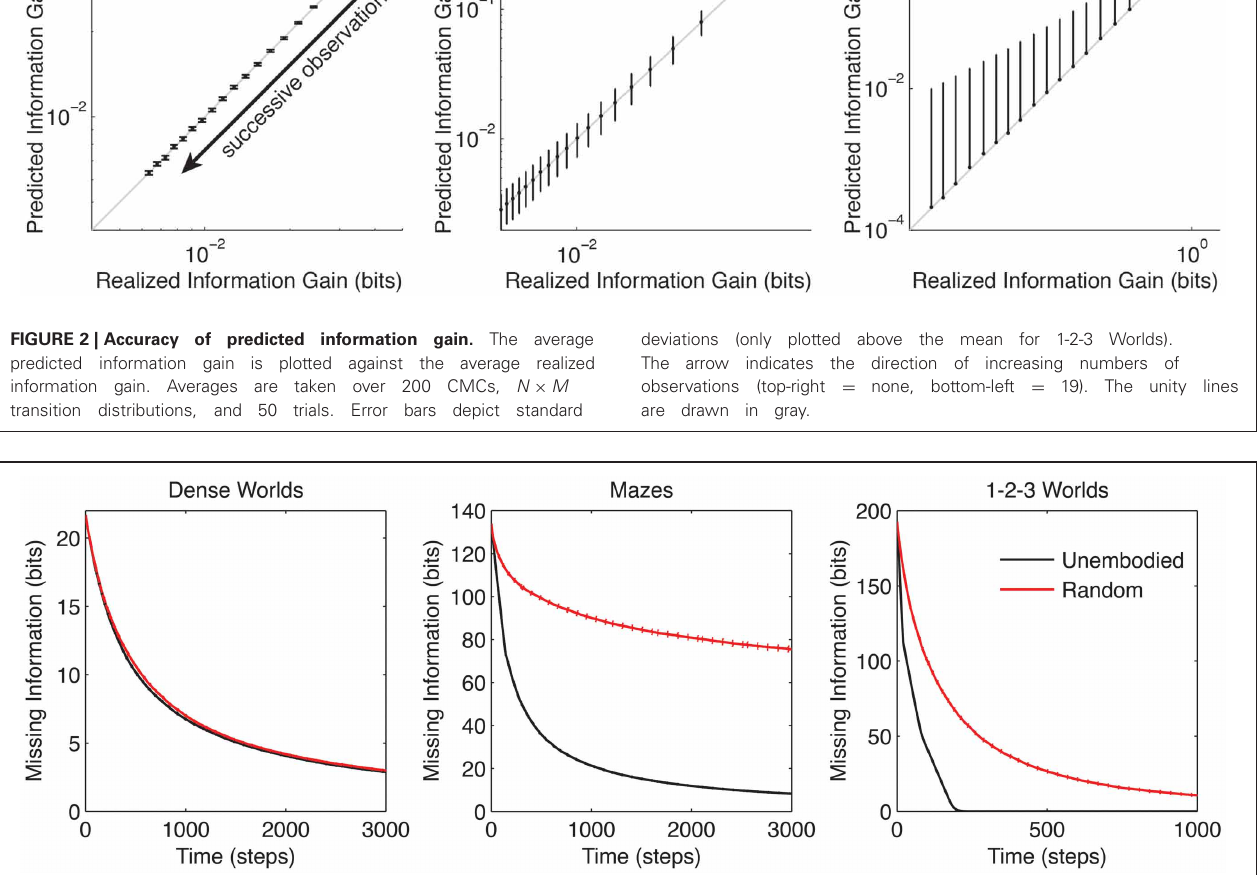
FIGURE 3 | Learning curves for control strategies. The average missing information is plotted over exploration time for the unembodied positive control and random action baseline control. Standard errors are plotted as dotted lines above and below learning curves ( n = 200).